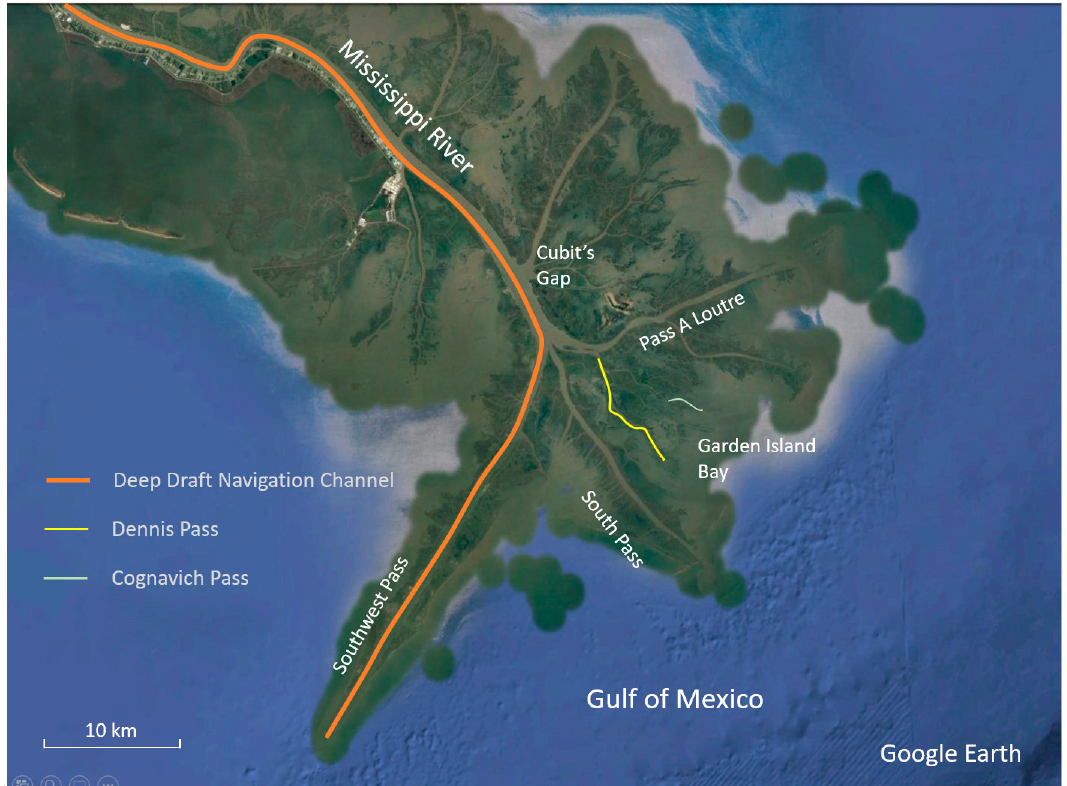
Figure 1. The Lower Mississippi River and the Bird’s Foot Delta comprised of numerous, branching distributary channels. One is dredged to allow deep draft, ocean-going vessels. Examples of smaller distributary channels are indicated in the Garden Island Bay subdelta showing Dennis Pass, which began building this subdelta in 1891, and Cognavich Pass. Dennis Pass originates from Pass A Loutre and is approximately 11,700-m long (150-m wide); Cognavich Pass is approximately 2000-m long 20-m wide.